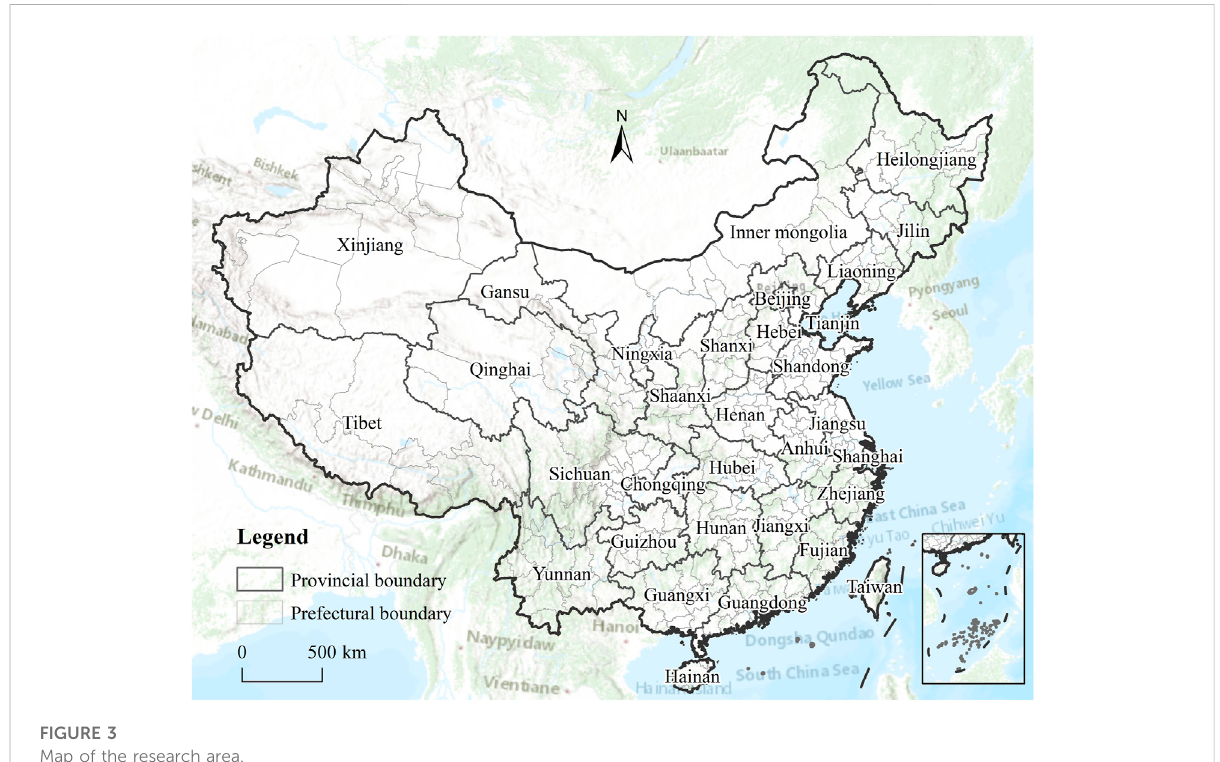
FIGURE 3 Map of the research